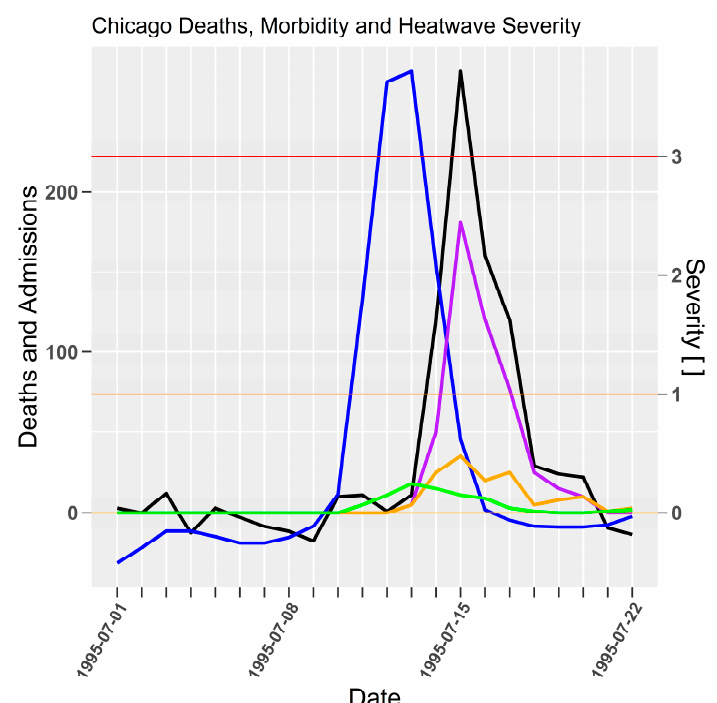
Figure 6. Chicago severity (blue), excess all cause deaths (black) (Whitman et al. [36] (p. 1517, Figure 2)), heat related mortality (purple) (Whitman et al. [36] (p. 1516, Figure 1)), heat deaths (gold) (Kaiser et al. [37] (p. S159, Figure 1)), and intensive care admissions (green) (Dematte et al. [38] (p. 174, Figure 1)) for 1995 heatwave. Daily deaths and admissions, and severity [] on left and right y -axes respectively.